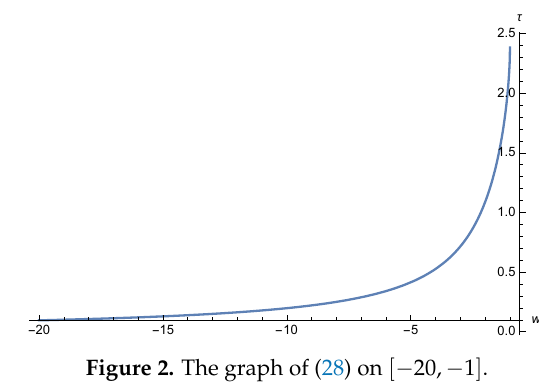
Figure 2. The graph of (28) on [ − 20, − 1 ] .